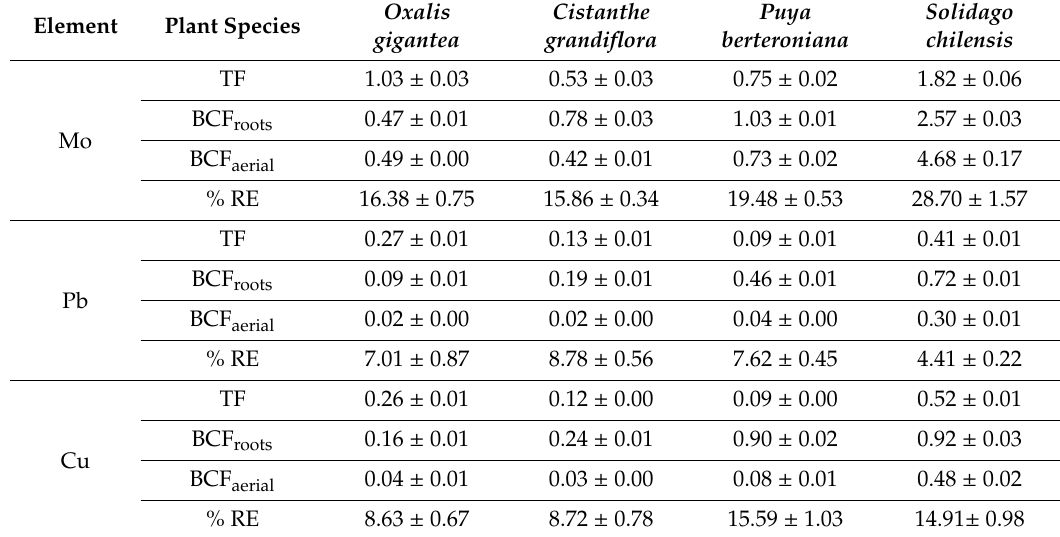
Table 4. Translocation factor (TF), bioconcentration factor (BCF) and removal e ffi ciency after the growth